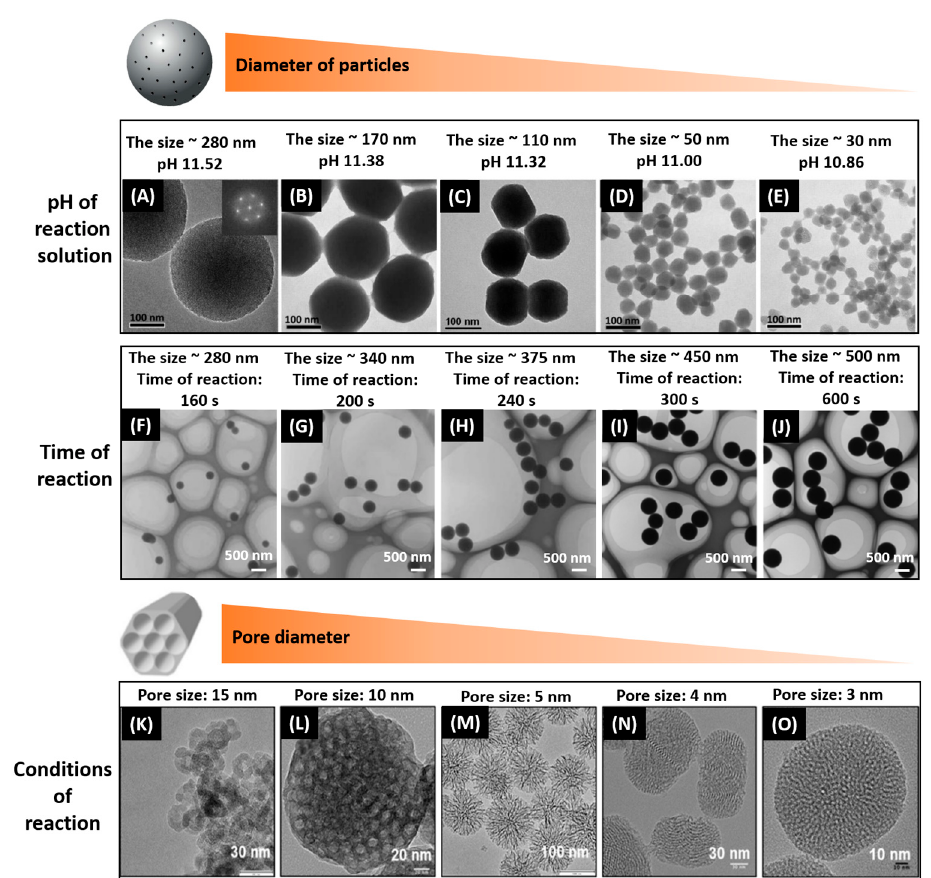
Figure 2. TEM images of silica-based carriers with tunable diameters and pore size. ( A – E ) Reproduced with permission from [31]. Royal Society of Chemistry, 2013; ( F – J ) Reproduced with permission from [33]. American Chemical Society, 2007; ( K – O ) Reproduced with permission from [45]. American Chemical Society, 2017.